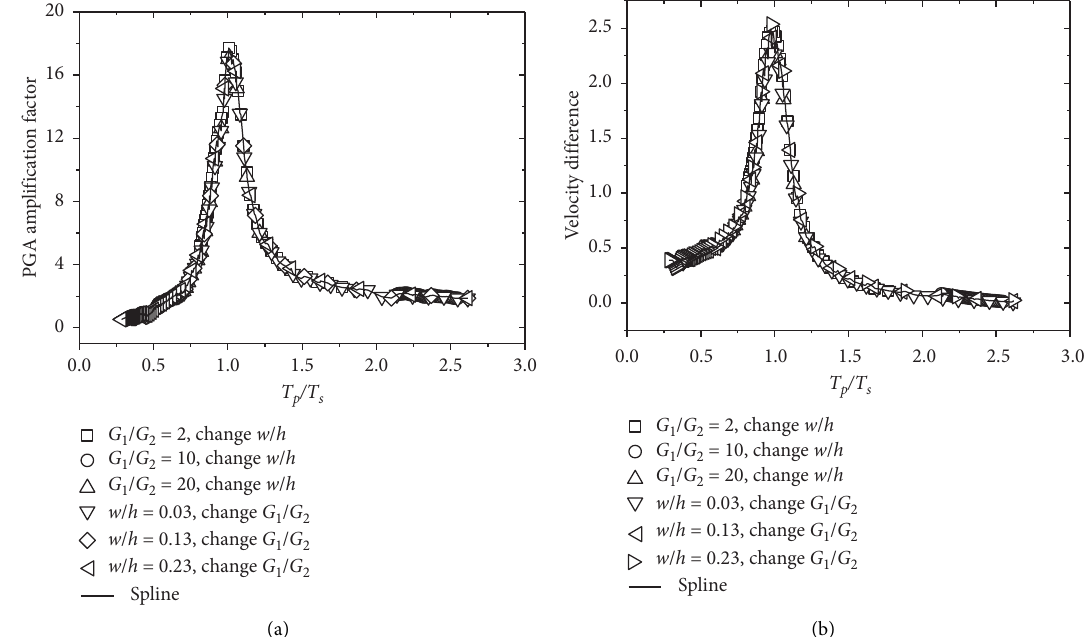
Figure 15: Relationship between dynamic response and T p / T s . (a) PGA amplification factor at the top of the slope. (b) Maximum velocity difference between the top and bottom of the interlayer.